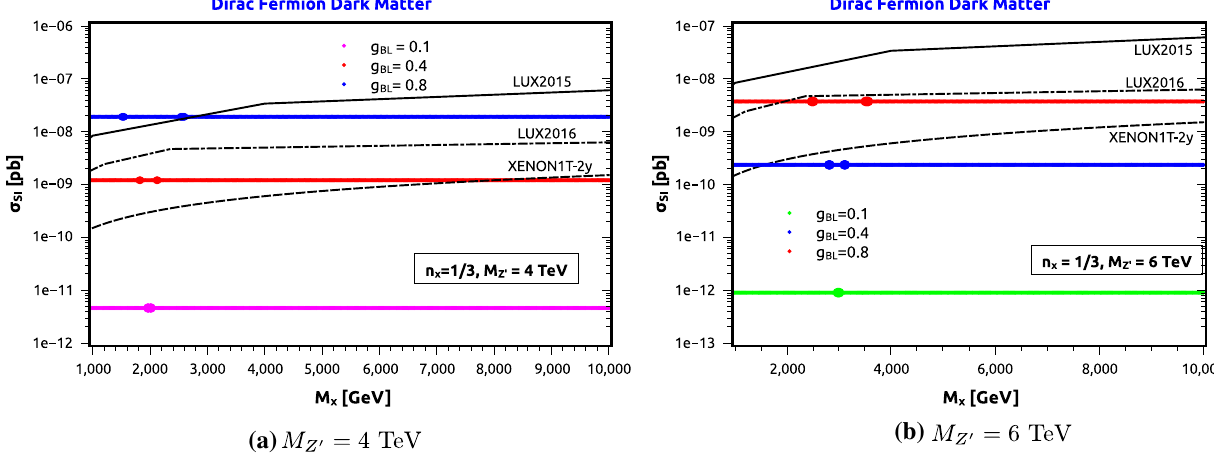
Fig. 5 Dirac fermion. Spin-independent dark matter–nucleon scatter- ing cross section as a function of the dark matter mass with n = 1 / 3 and M Z (cid:2) = 4 , 6 TeV for different gauge couplings, g BL = 0 . 1 , 0 . 4 , 0 . 8.